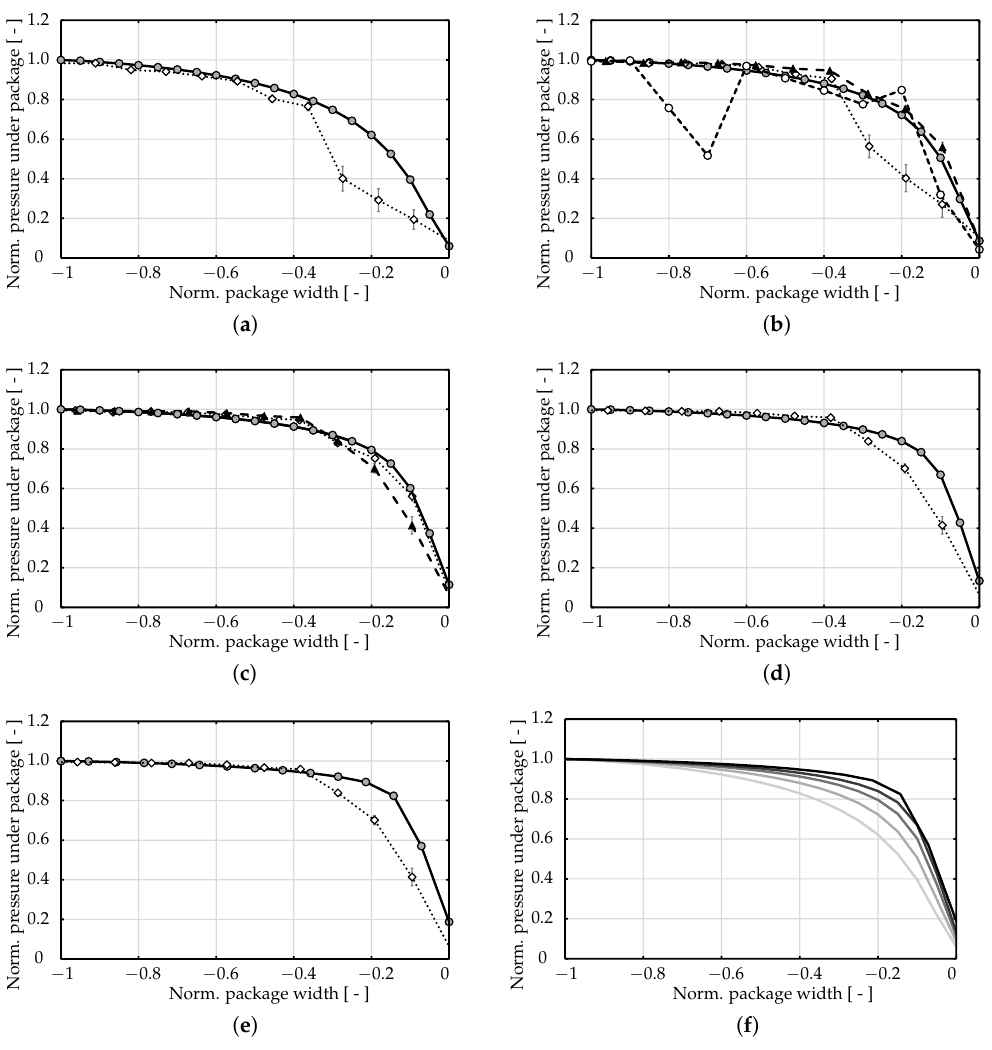
Figure 6. Norm. pressure under the package plotted against the norm. package width, ( a ): CFD ( ), Schur et al. [31] ( ), both ∆ p = 1.0bar; ( b ): CFD ∆ p = 2.5bar